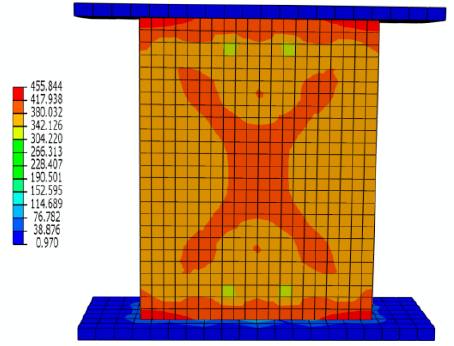
Figure 17. Distribution of Steel under Peak Load (MPa).